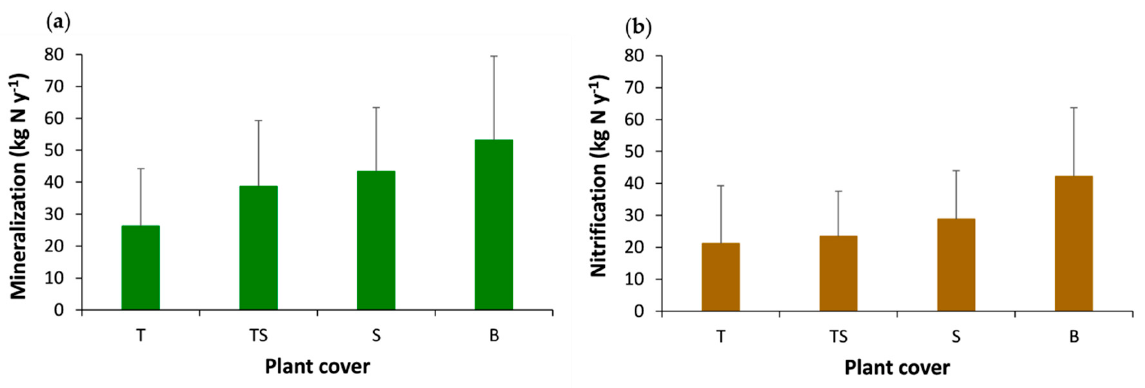
Figure 5. Effect of plant cover on net annual N mineralization ( a ) and net annual nitrification ( b ).